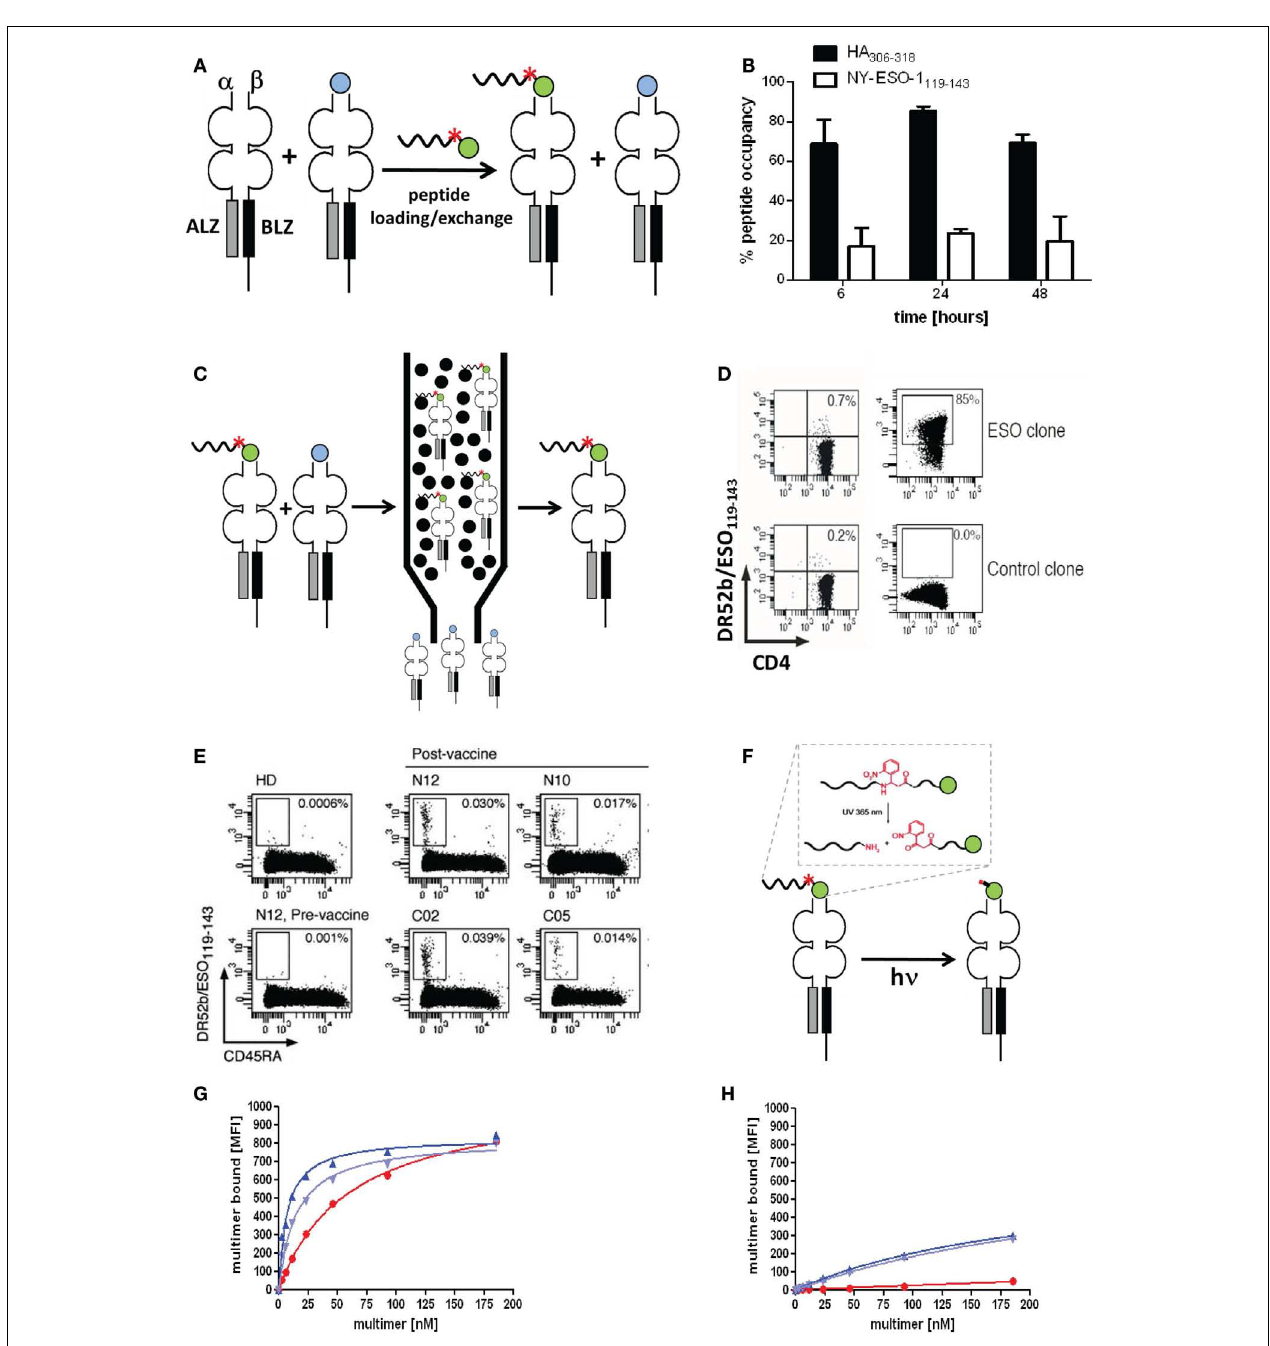
FIGURE 5 | Molecularly defined pMHC class II multimers detect low avidity CD4 + T cells . (A,C,F) Cartoons illustrating the use of photocleavable (red asterisk) peptide tags to discriminate pMHC II complexes containing the peptide of interest (green ball) or irrelevant peptides (blue ball) (A) , to affinity purify correctly loaded complexes (C) and to remove the peptide tag, either His 6 or desthiobiotin that is linked to the peptide via a β -nitrophenylglycine residue, which can be cleft by UV irradiation. (B) “Empty” HLA-DR4 was incubated for 6, 24, and 48h at 37°C at pH 6, 32°C for 4h with His 6 -HA 306–318 (black bars) or His 6 -NY-ESO-1 119–143 (white bars). Peptide occupancy was calculated as (amount of His 6 -peptide bound to the DR4)/(amount of total DR4). After gel-filtration the peptide occupancy was determined by ELISA using affinity-purified complexes as reference (100%).